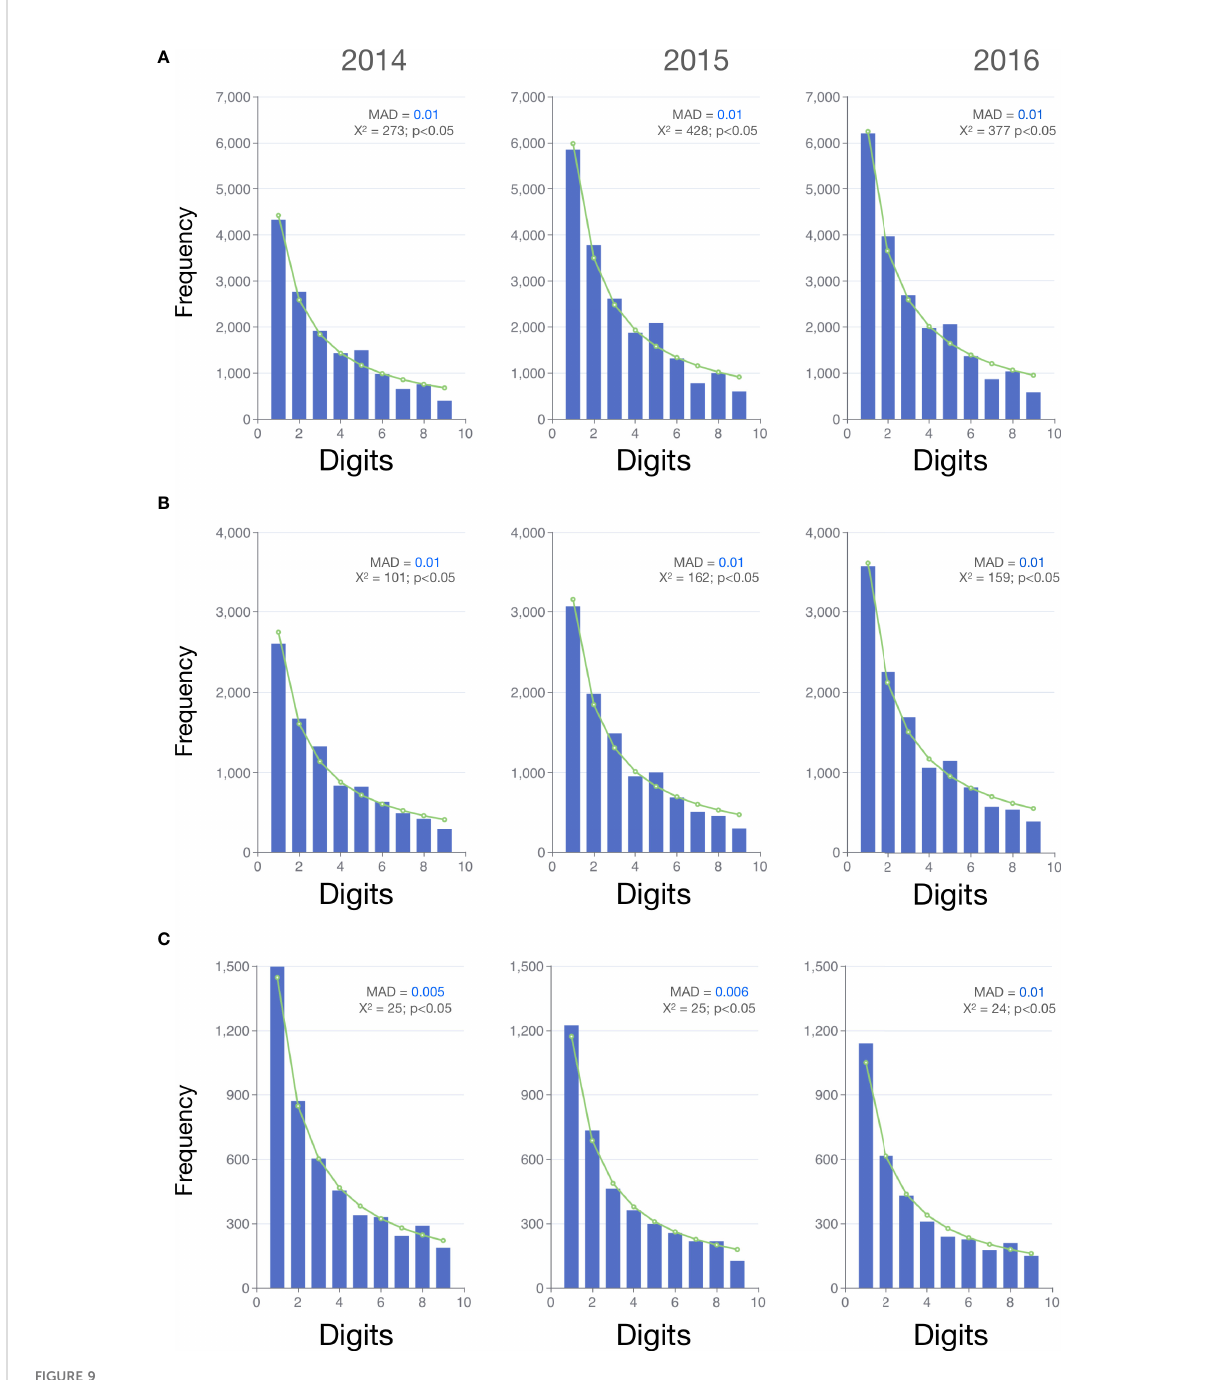
FIGURE 9 Monthly data frequency distribution of the fi rst digits of motorized canoes (A) , non-motorized canoes (B) , and motorized boats (C) (blue bars) and the expected Benford distribution (green line) for each of the study years. MAD values higher or equal to 0.015 are considered as not in conformity with Benford ’ s law (Nigrini,